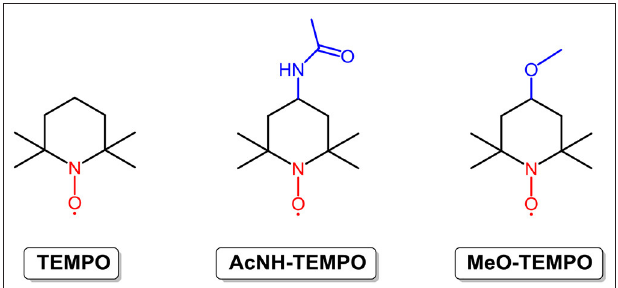
FIGURE 4 | Molecular structures of TEMPO